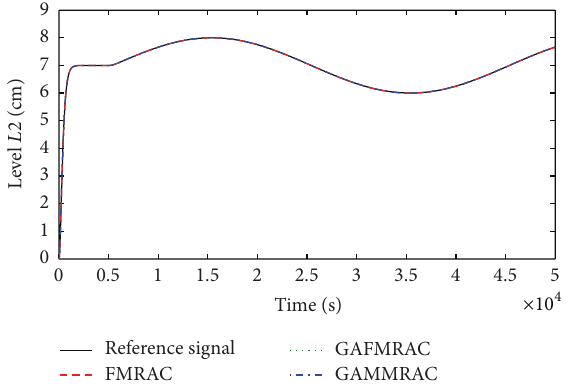
Figure 10: Response of the three controllers to a step input followed by a sinusoidal input.